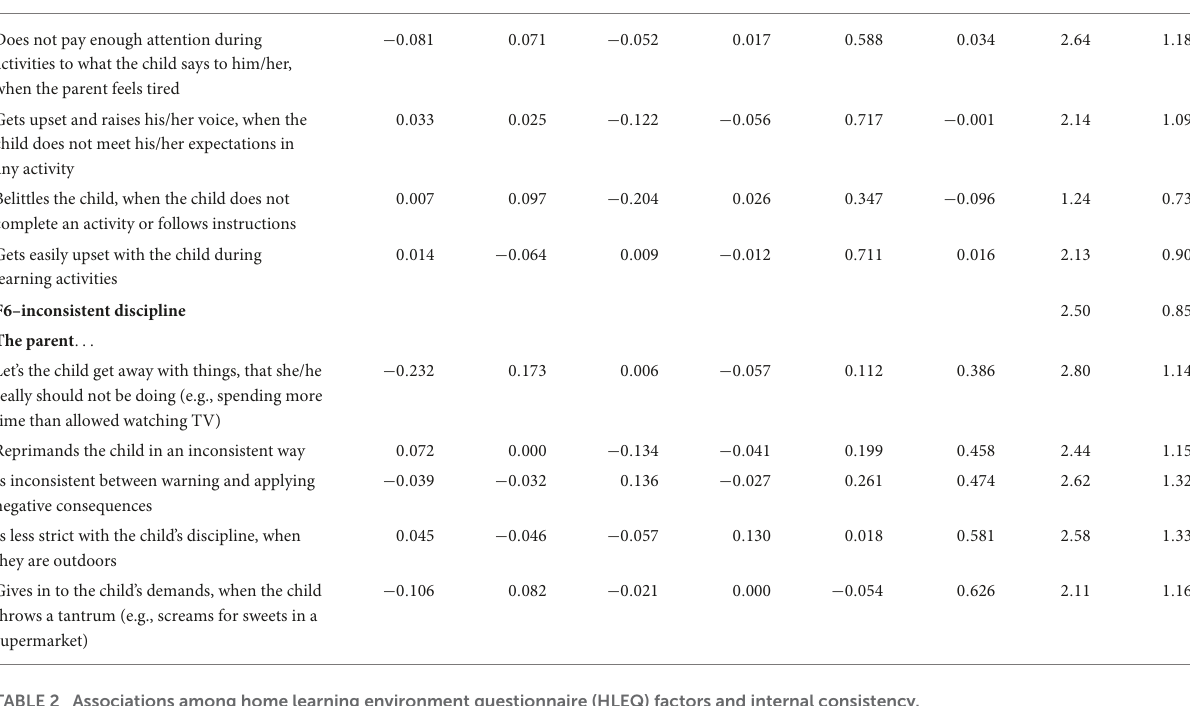
TABLE 2 Associations among home learning environment questionnaire (HLEQ) factors and internal consistency.